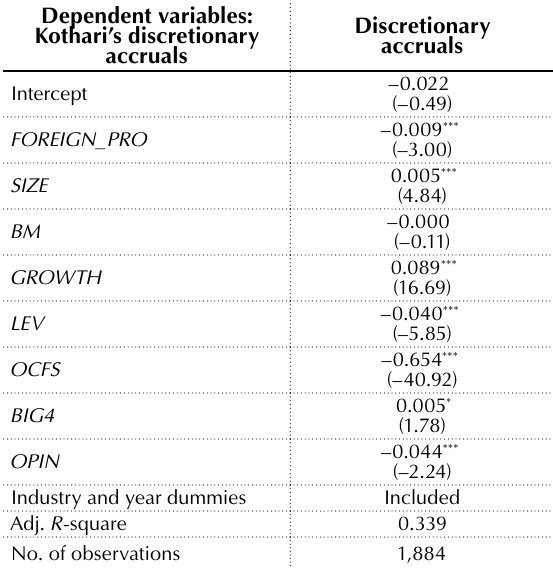
Table 8. The effect of foreign